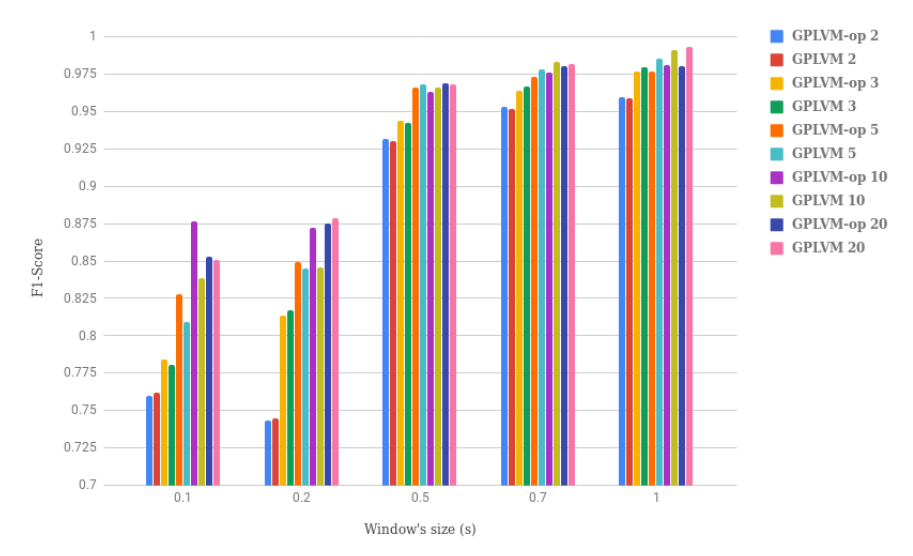
Figure 10. F1-score values for the different types of feature based classification (optimized (op) and non-optimized GPLVM inference), sampling window’s size (0.1, 0.2, 0.5, 0.7, and 1.0 s), and number of